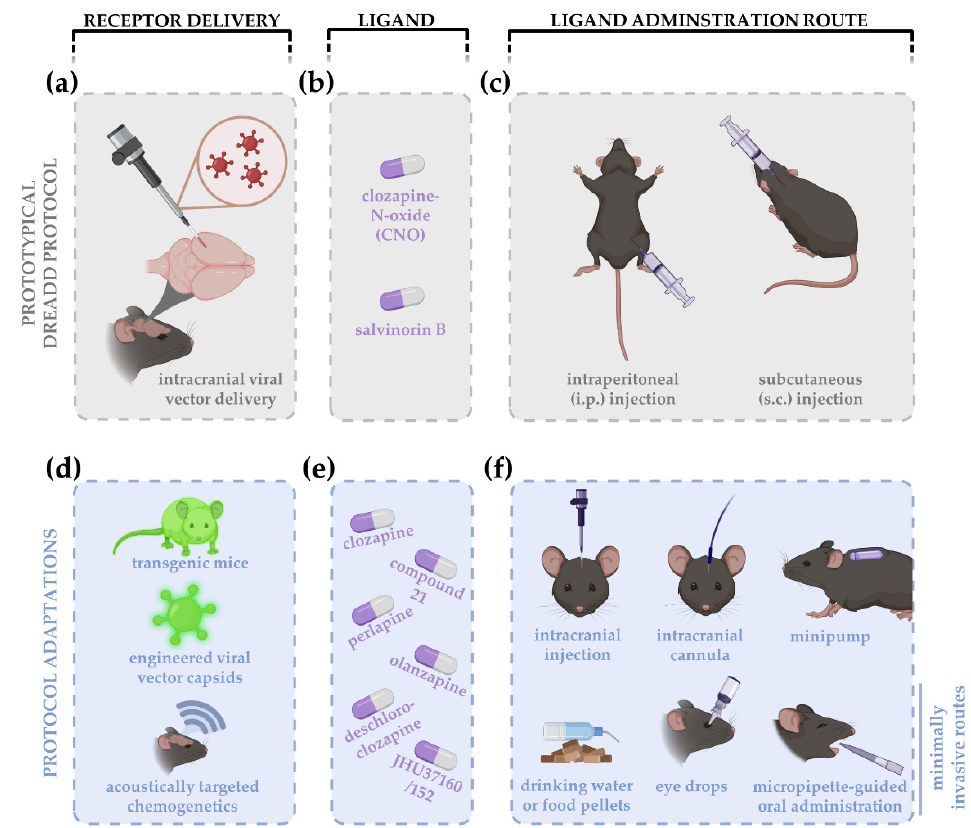
Figure 1. Schematic overview of a prototypical DREADD experiment ( a – c ) and protocol adaptations ( d – f ) introduced over the past years. A prototypical experiment consists of intracranial viral vector delivery of the DREADD construct ( a ). The archetypical DREADD ligand clozapine-N-oxide (CNO) (for hM3Dq, hM4Di, hM3Ds, or rM3D DREADDs), or salvinorin B (for KOR DREADDs), are typically administered via intraperitoneal (i.p.) or subcutaneous (s.c.) injections ( b , c ). DREADD delivery